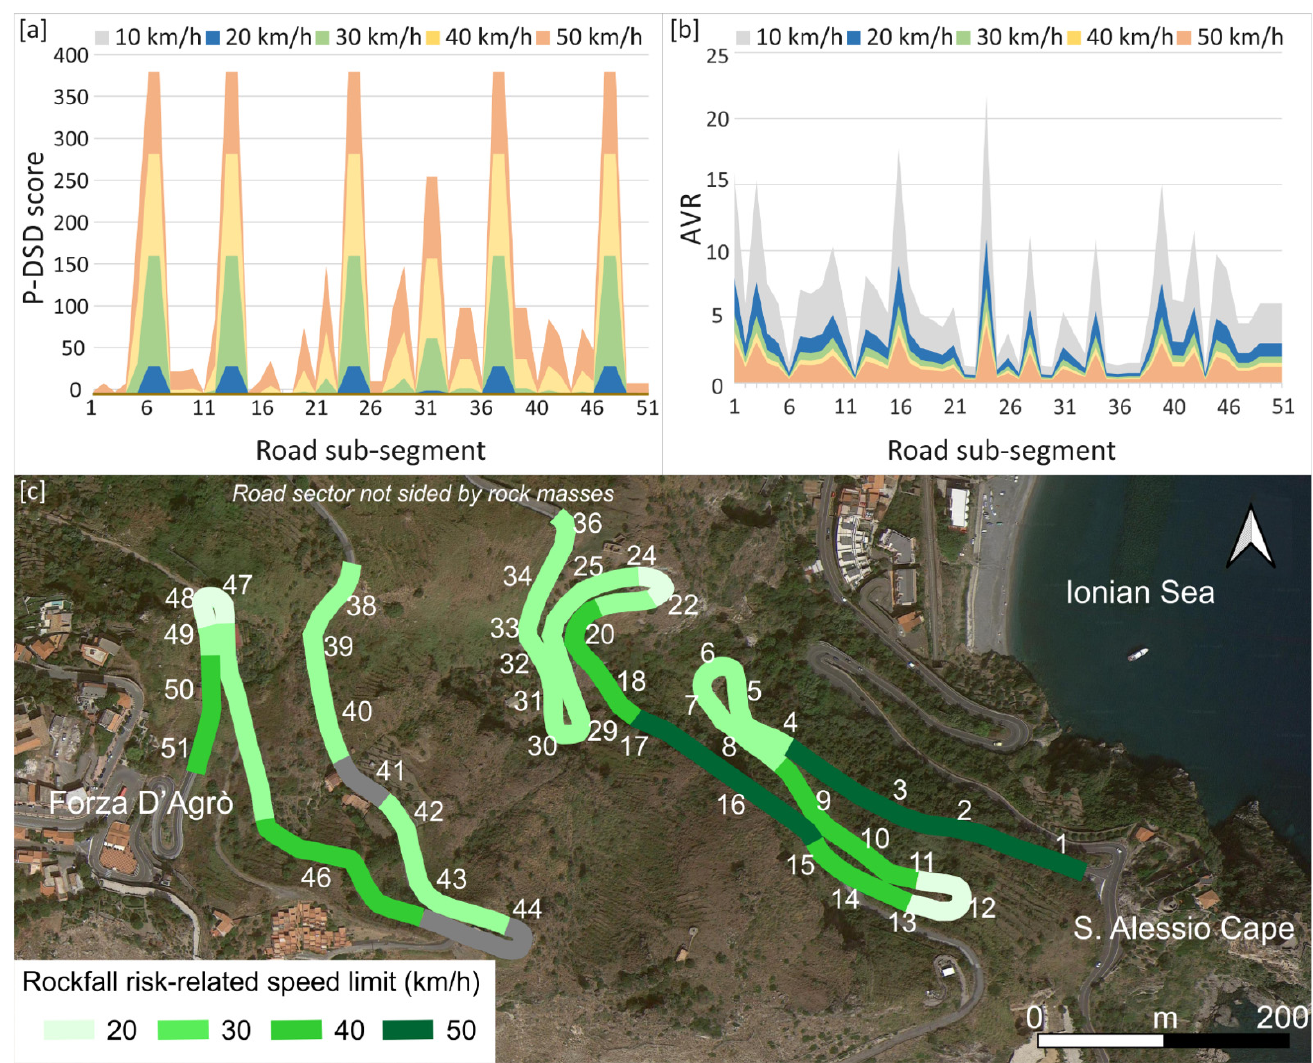
Figure 7. Variation of the P-DSD-related score ( a ) and the AVR parameter ( b ) along the road according to the different vehicle speed scenarios; ( c ) likely rockfall-risk-related speed limit zonation resulting from this study. The gray band indicates road segments surrounded by no rock masses.